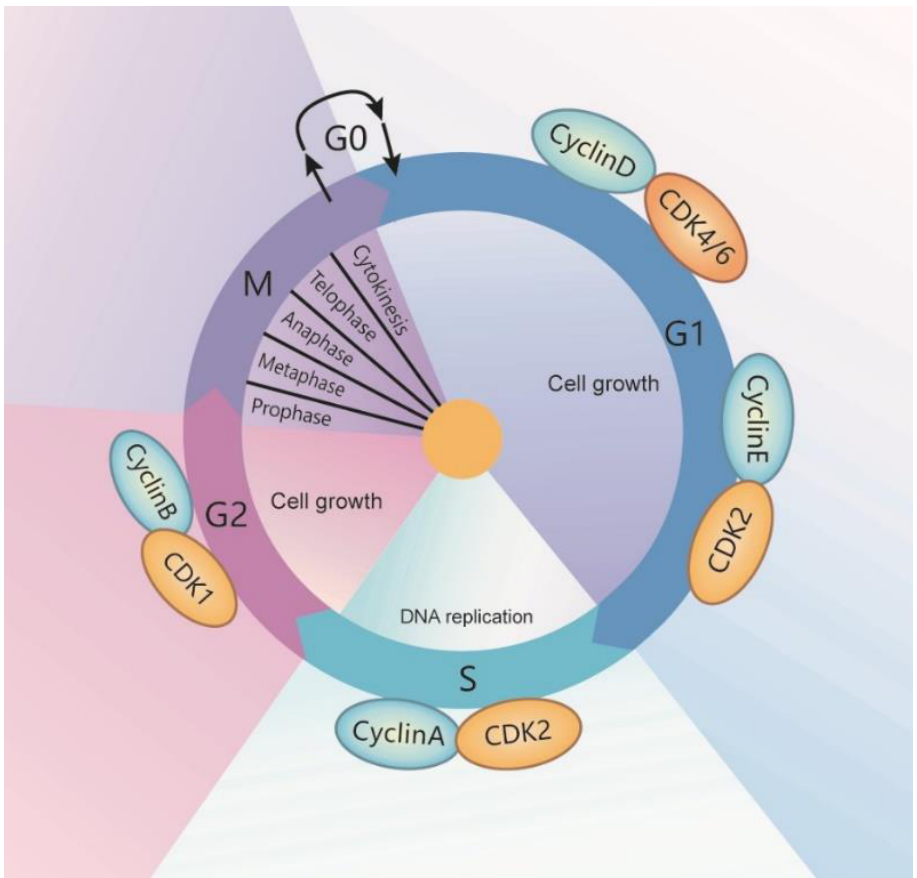
Figure 1. Schematic representation of the cell cycle. The cell cycle is divided into interphase (G1, S, G2) and mitotic phases. Nondividing cells are in G0. Cell cycle progression is controlled by cyclin/cyclin-dependent kinase (CDK) complexes in specific cell cycle phases. During the cell cycle, there are three checkpoints that occur at the end of G1 and the transition of G2/M, and in metaphase. The G1 checkpoint blocks the entry of the cell cycle into the S phase if a cell does not fulfill all the conditions, which lets the cell try to solve the conditions, or lets the cell enter into the G0 phase. The G 2 checkpoint bars the entry of the cell cycle into the mitotic phase if certain conditions are not met, which ensures that all of the genetic material has been replicated and is not damaged. A damaged DNA will halt the cell cycle to let the damaged DNA be repaired. The M checkpoint, also named as the spindle checkpoint, is a point close to the end of the metaphase stage to make sure whether each pair of sister chromatids is correctly anchored to the two spindle microtubules—if not, the cycle will be halted. Recent studies suggest that RNA helicases are involved in these